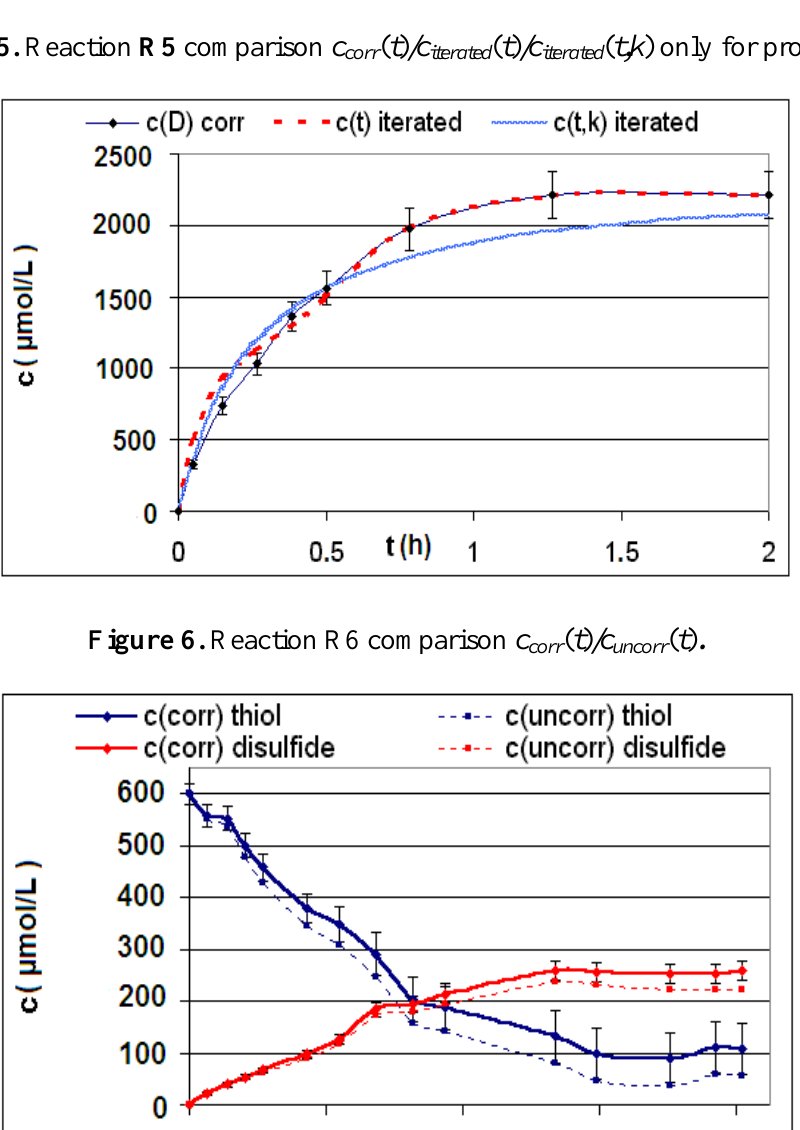
Figure 5. Reaction R5 comparison c